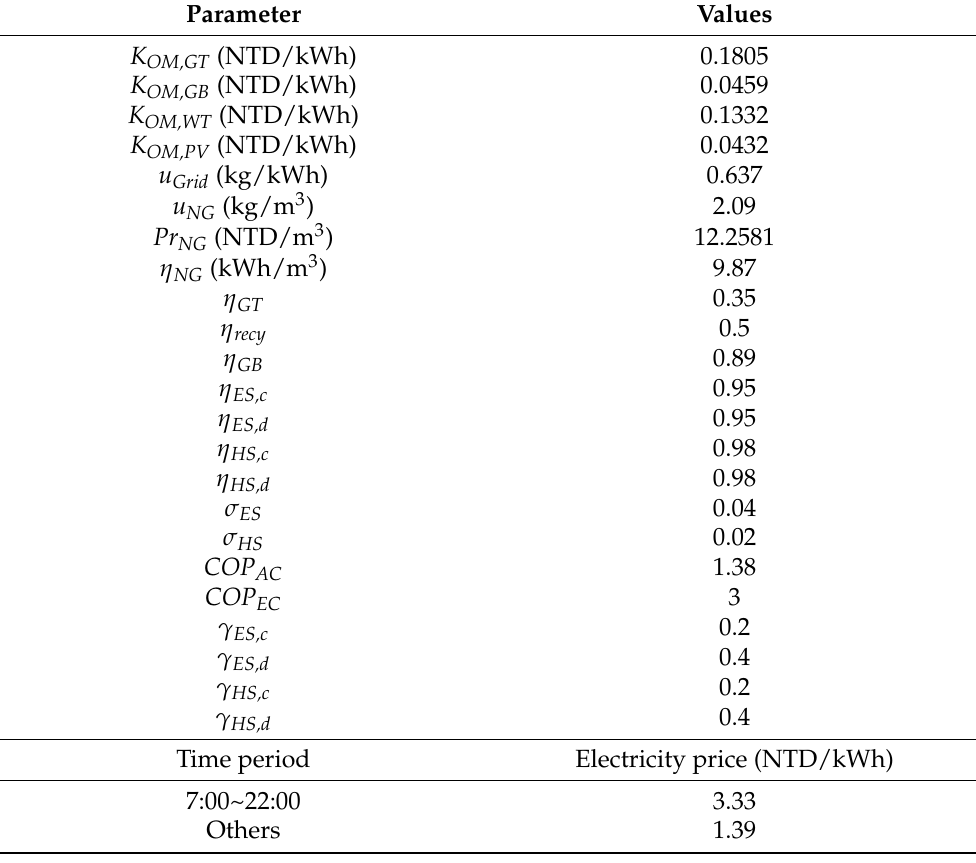
Table 1. The parameter values of the system and the electricity price of the time period.